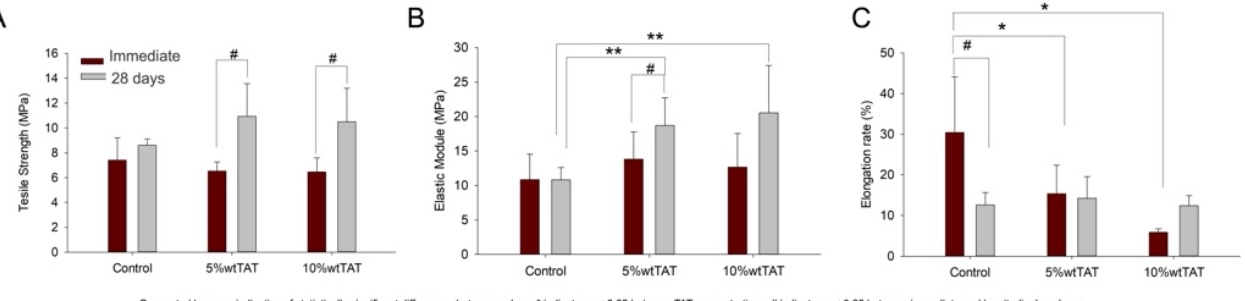
Figure 2. Mechanical behavior of developed barrier membranes. The addition of TAT modified the tensile strength ( A ), the elastic modulus ( B ), and the elongation rate ( C ) in PBAT films. Bars are a description of average values, while error bars represent standard deviations. Connected bars are indicative of statistically significant differences between values. * Indicates statistically significant differences between TAT concentrations and # between immediate and longitudinal analyses. * p < 0.05; ** p <